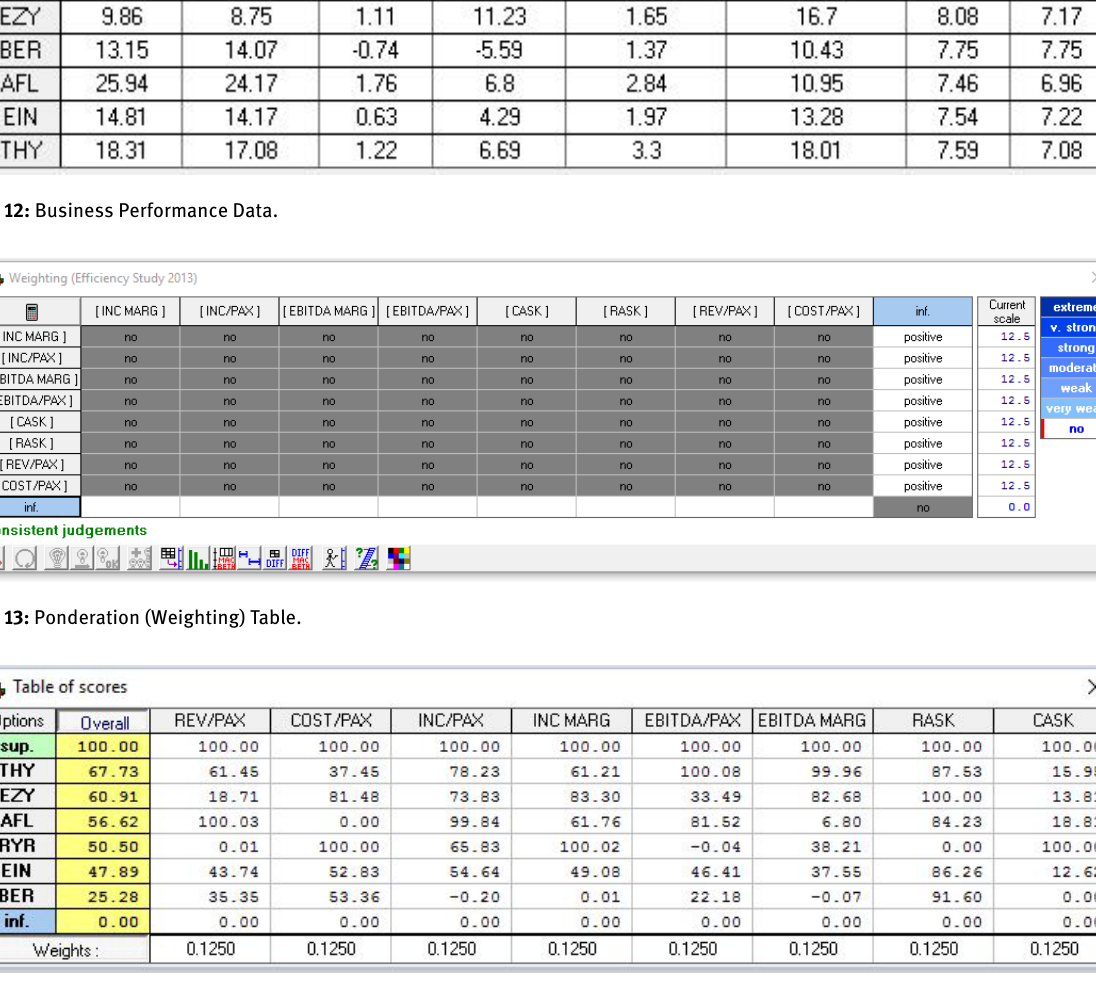
Figure 14: Table of Scores: